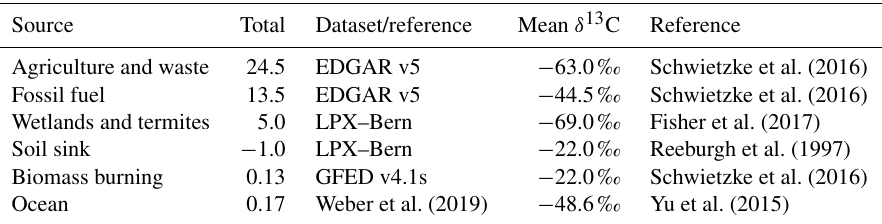
Table 2. The prior fluxes and δ 13 C value used for each source where the total and mean δ 13 C values are given for the European